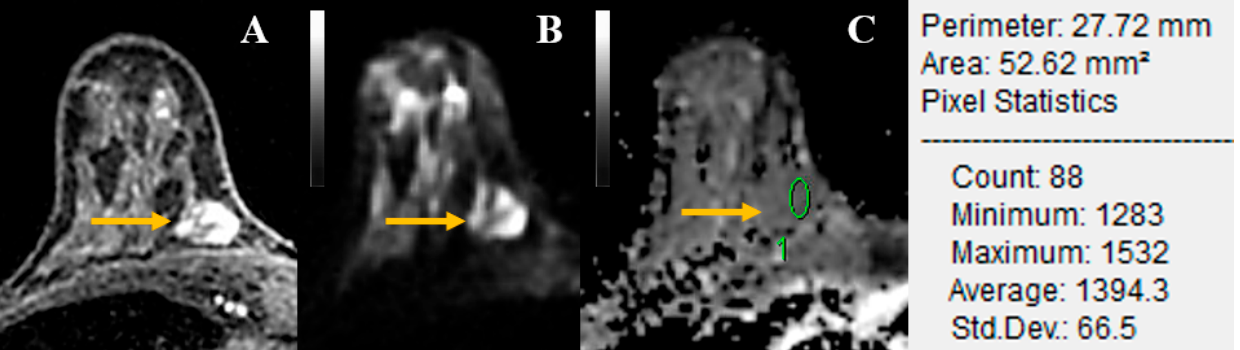
Figure 2. Axial MR images of a 48-year-old woman with a 14-mm benign mass in the right breast, of which biopsy yielded fibro-adenomatoid changes (yellow arrows). ( A ) Axial dynamic contrast- enhanced image depicts a heterogeneous, oval, and circumscribed enhancing mass in the right breast corresponding to a heterogeneous hyperintense lesion on axial diffusion-weighted imaging (DWI) at a b value of 800 s/mm 2 ; ( B ). ( C ) Correlative parametric apparent diffusion coefficient (ADC) map with a region of interest (ROI) placed within the darkest part of the lesion and ROI information. ADC values are expressed in mm 2 /s. This lesion was heterogeneous vs. non-enhancing septa and therefore characterized as BI-RADS 3 and 3 based on the DWI score in the consensus reading of radiologists.